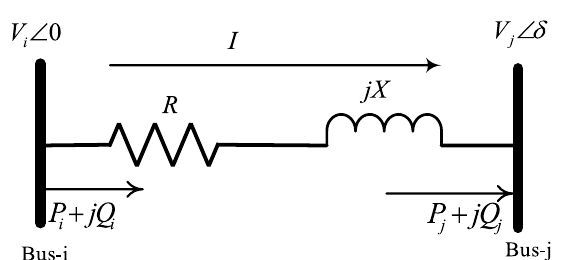
Fig. 1 Single line diagram of power transmission